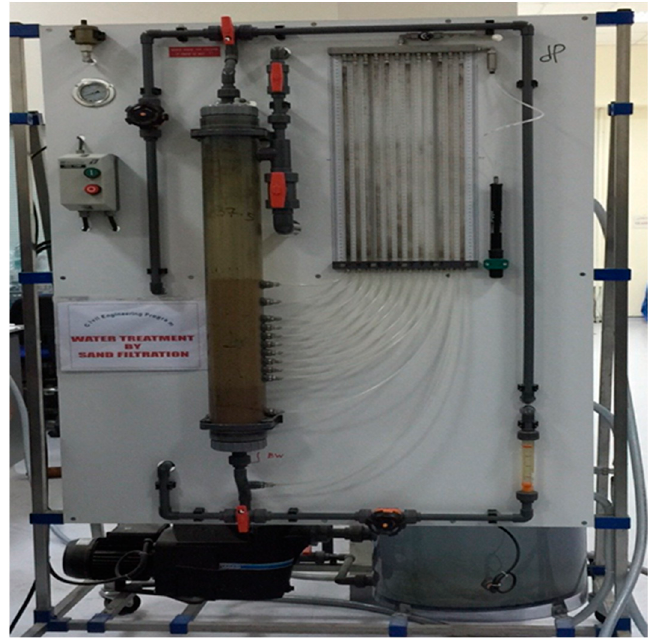
Figure 2. Sand filtration experimental